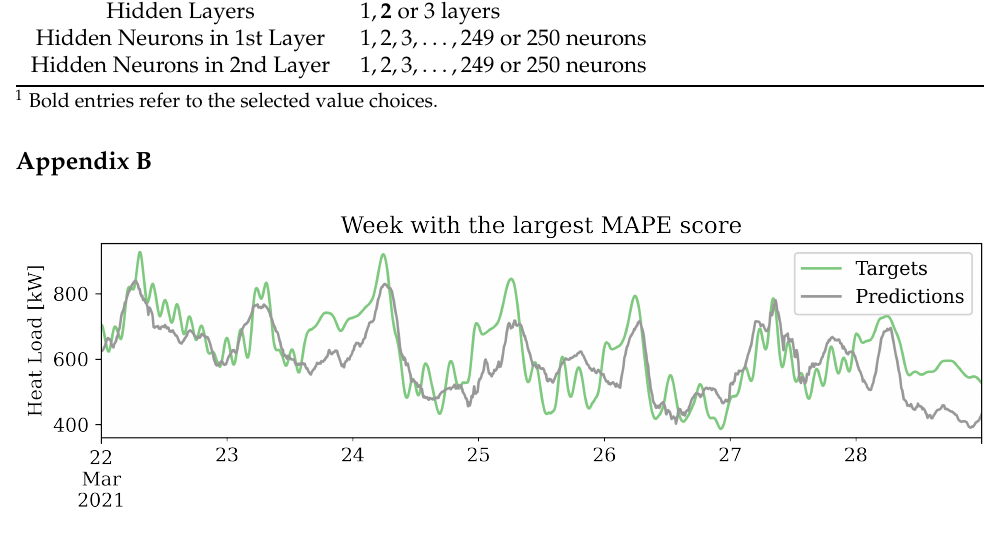
Figure A1. The largest MAPE score of 11.5% over one week is produced by the +39-model and not the model with the largest forecast horizon. The predicted values by the +39-model (predictions) and the real observations for the same period (targets) are displayed for that specific week in March